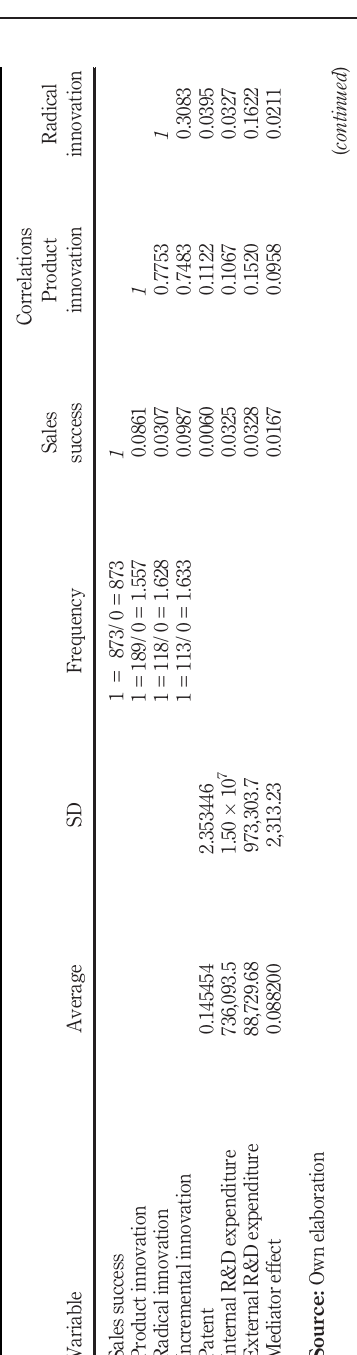
and Pearson correlation